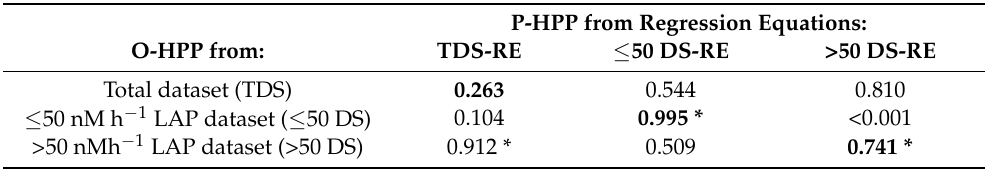
Table 6. U values of Mann–Whitney pairwise comparisons calculated between the observed (O-HPP) and the predicted (P-HPP) values of heterotrophic prokaryotic production (HPP). The datasets and regression combinations used in the building of the P-HPP along the water columns are reported in bold (reported in Figure 3), namely the comparisons between O-HPP and P-HPP obtained from Total dataset, ≤ 50 nM h − 1 LAP and >50 nM h − 1 LAP datasets. The asterisks indicate the combinations giving the best matches between O-HPP and P-HPP. Abbreviations: TDS-RE, Total Dataset Regression Equation; DS-RE, Dataset Regression Equation obtained with the two concentrations of Leucine AminoPeptidase (LAP ≤ 50 nM h − 1 and >50 nM h − 1 ). P-HPP from Regression